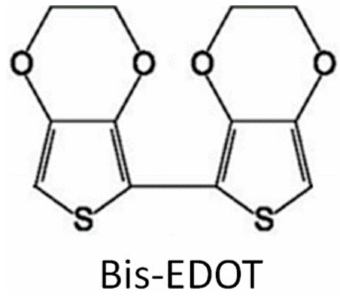
Figure 1. Chemical structure of dimer of 3,4-ethylendioxythiophene